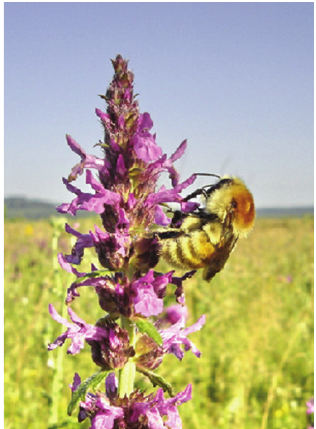
Figure 8: B. terrestris foudress queen foraging from Echium vulgare flower.